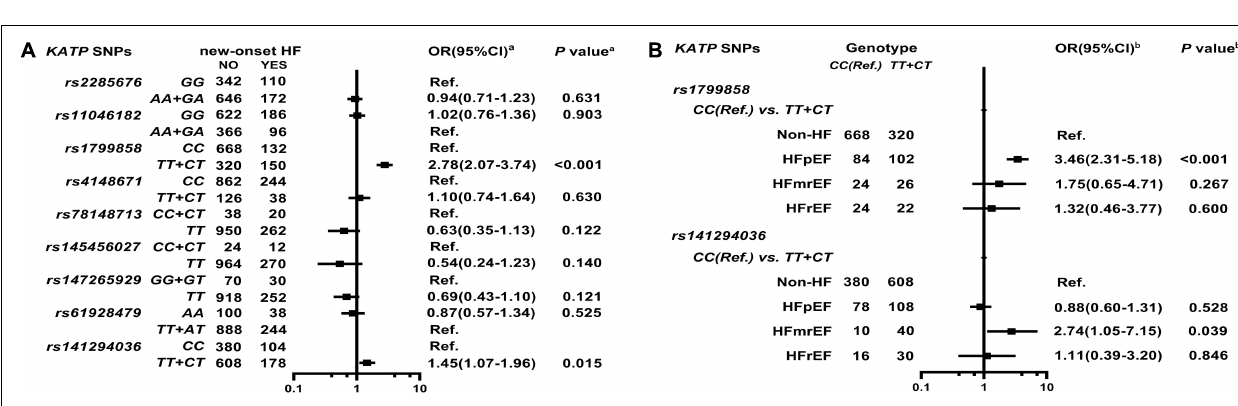
FIGURE 4 | Association of KATP SNPs with incidence of HF in the study participants. a Model (A) After adjustment for gender, age, smoking, alcohol consumption, BMI, WBC, blood glucose levels (FBS, P2hBS, and HbA1C), liver function (ALT, AST, and Alb), renal function (Scr, BUN, and UA), serum sodium and potassium levels, HsCRP, RAAS activity (ACE, renin, Ang I, Ang II, and ALD), dyslipidemia [TRIG, TC, LDL-C, ApoB, HDL-C, ApoA-I, and Lp(a)], medical condition [T2D, HTN, CAD(ACS), and AF], echocardiography index (RVD, RAD, LVD, LAD, and LVEF), and combined medication (antiplatelet drugs, warfarin, statins, RSIs, BBs, MRA, CCBs, diuretics, digoxin, nitrates, and hypoglycemic agents). b Model (B) It is the same as Model (A) .